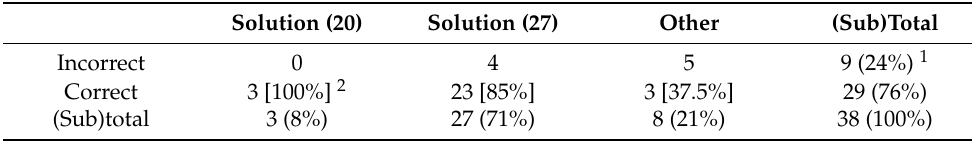
Table 2. Summary of solving the first-order linear ODE in the assignment in